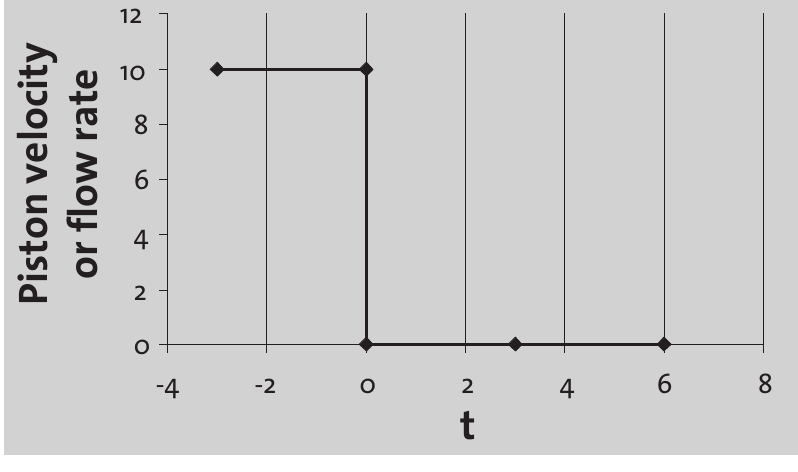
Figure 5 (left below): Flow rate used in stress relaxation